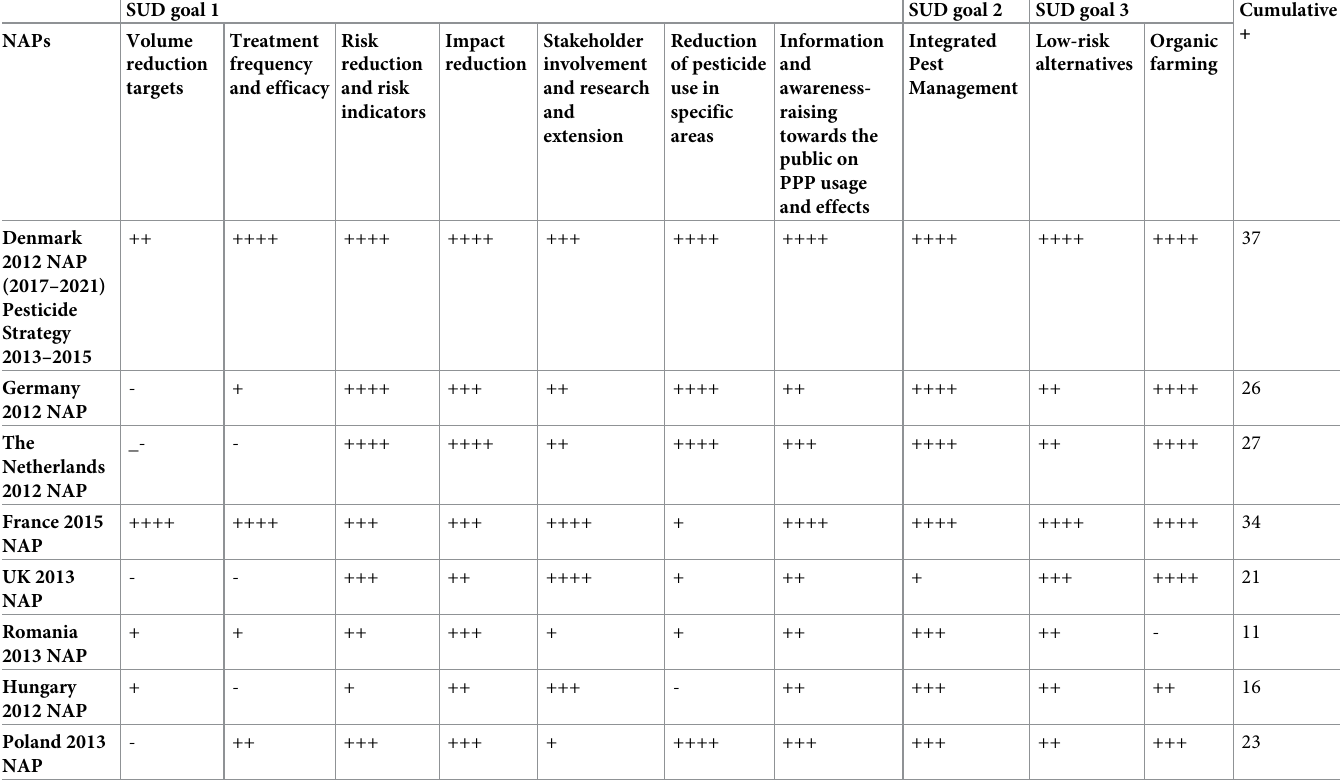
Table 3. Comparative synthetic investigation of the National Action Plans of Denmark, Germany, the Netherlands, France, the UK, Romania, Hungary, and Poland (synthetic data from Tables 1 and 2). SUD goal